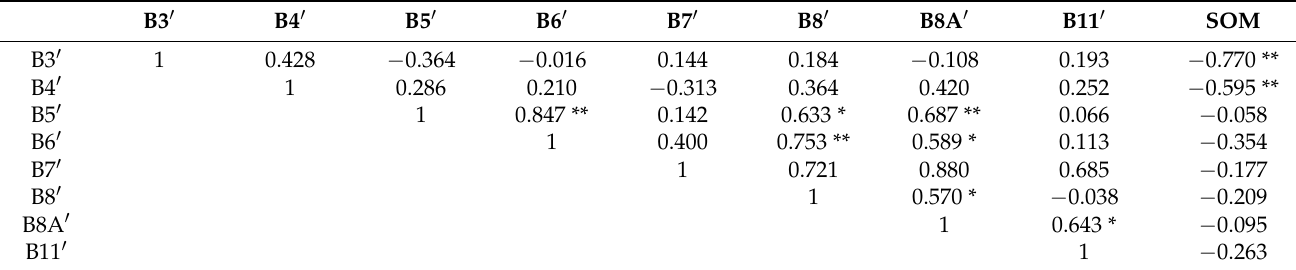
Table 4. The correlation between first-derivative image data and SOM.